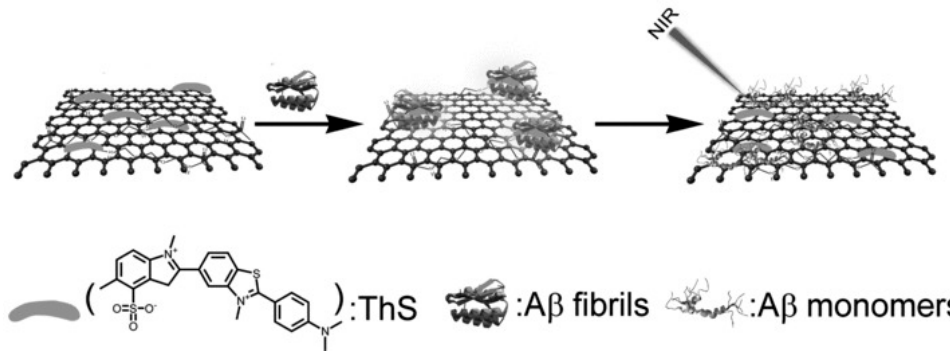
Figure 4. Schematic representation of the GO-ThS system used for AD treatment. Upon NIR irradiation, the GO-ThS system can dissolve the A β amyloid deposits. Republished with permission from Ref. [15]. Copyright 2022 John Wiley and Sons.